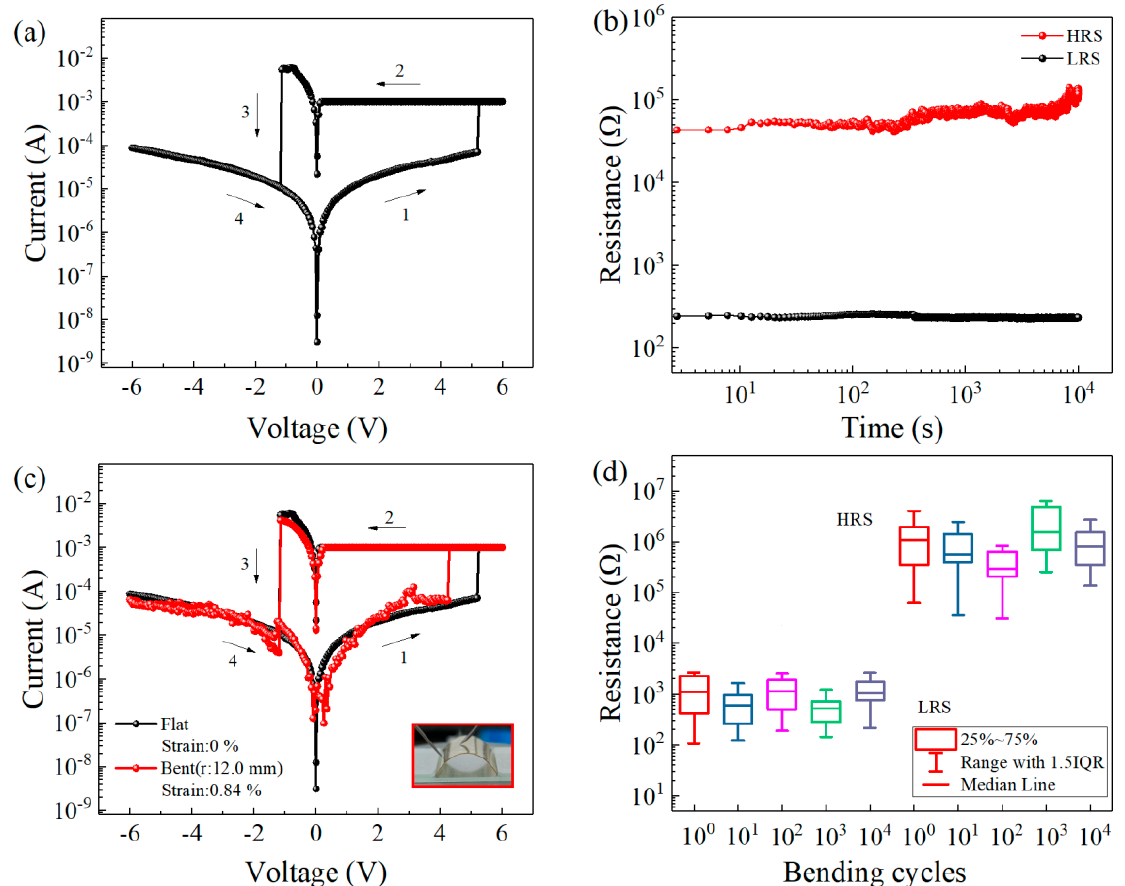
Figure 2. Al/TH/ITO/PET device: ( a ) current-voltage characteristic curve at the applied compliance current in the positive scan area. ( b ) retention time of the device. ( c ) I–V characteristic curve (flat and curved) when the compliance current is applied in the positive voltage region. ( d ) relationship between the number of bending cycles and the resistance state of the device.